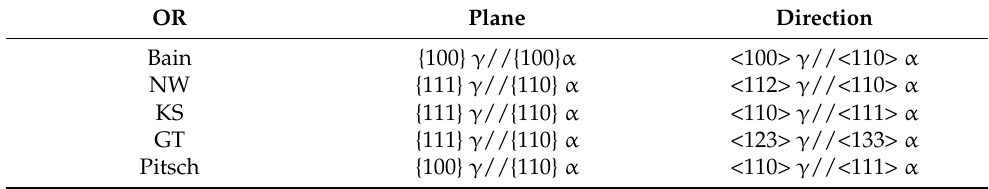
Table 1. Observed orientation relationships (ORs) between austenite, γ , and martensite, α ’, in steels. OR Plane Direction Bain {100} γ //{100} α <100> γ //<110> α NW {111} γ //{110} α <112> γ //<110> α KS {111} γ //{110}